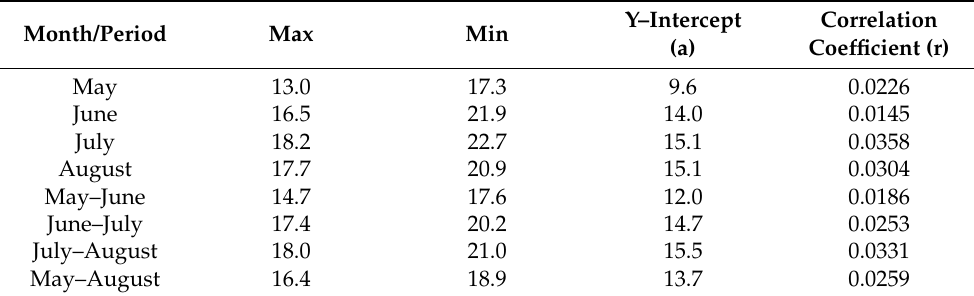
Table 4. Extreme values and regression equations characterizing changes in the average air tempera- ture in the period 1961–2020 with correlation coefficients characterizing a linear